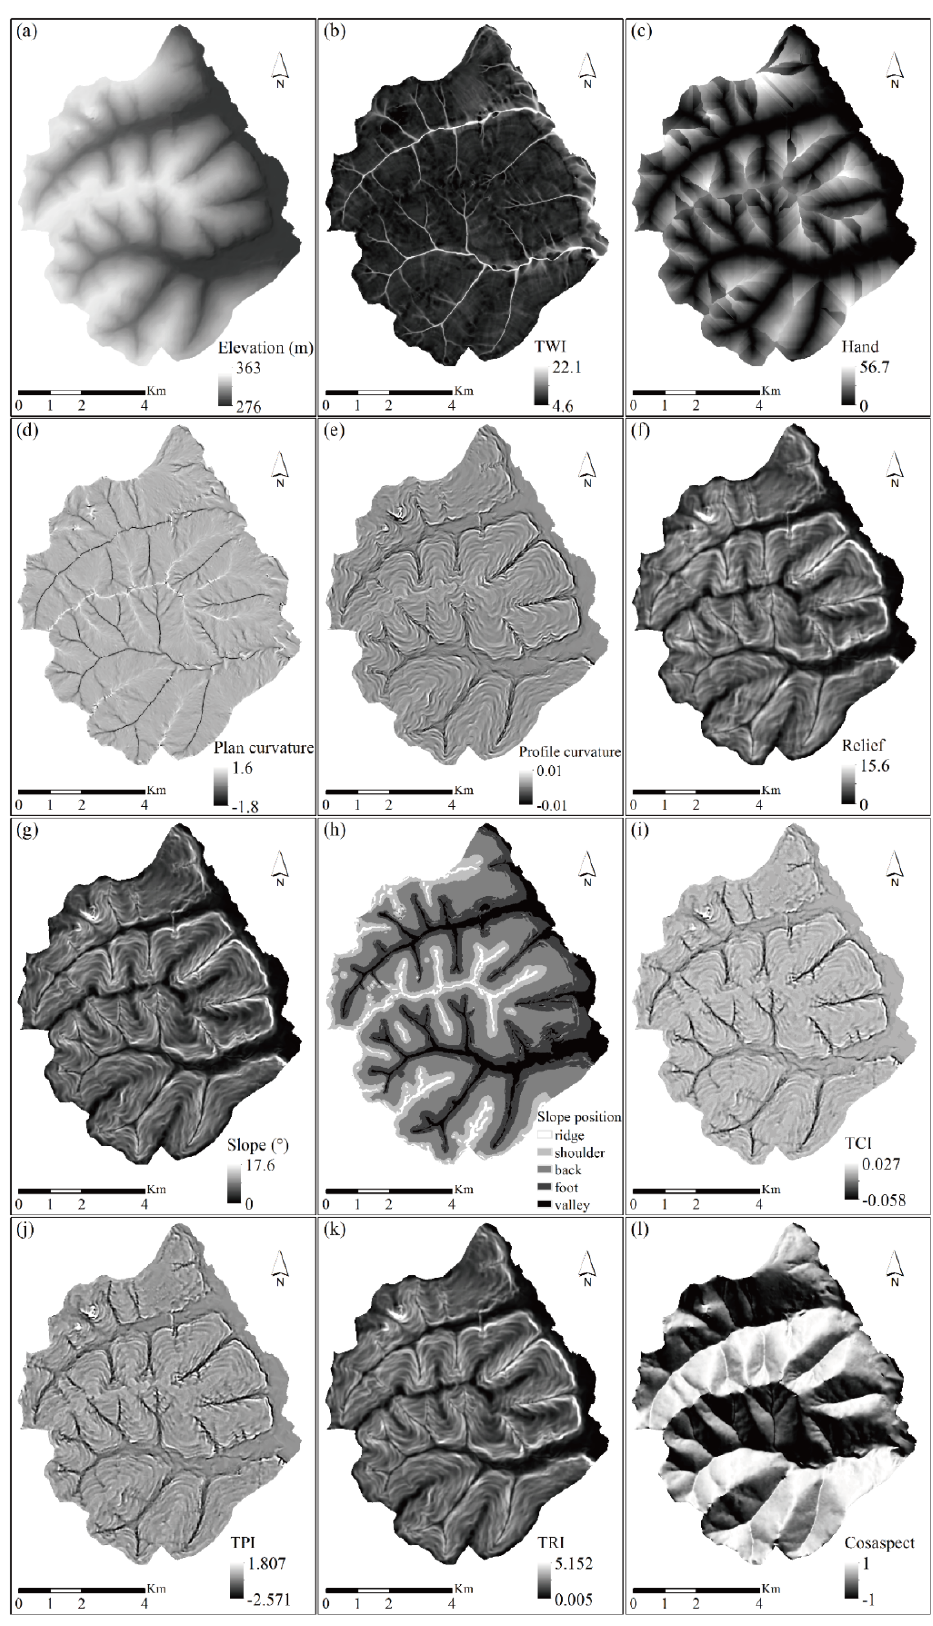
Figure 2. Environmental covariates: ( a ) Elevation, ( b ) Topographic wetness index (TWI), ( c ) Height above the nearest drainage (Hand), ( d ) Plan curvature, ( e ) Profile curvature, ( f ) Relief, ( g ) Slope, ( h ) Slope position, ( i ) Terrain characterization index (TCI), ( j ) Topographic position index (TPI), ( k ) Terrain ruggedness index (TRI), ( l ) Cosine value of the aspect (Cosaspect).